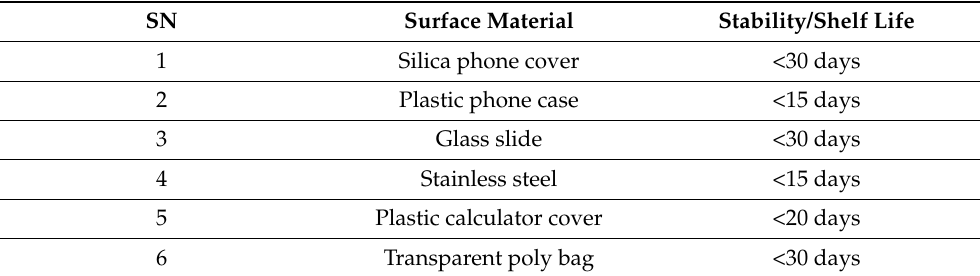
Table 2. Stability shelf life of developed